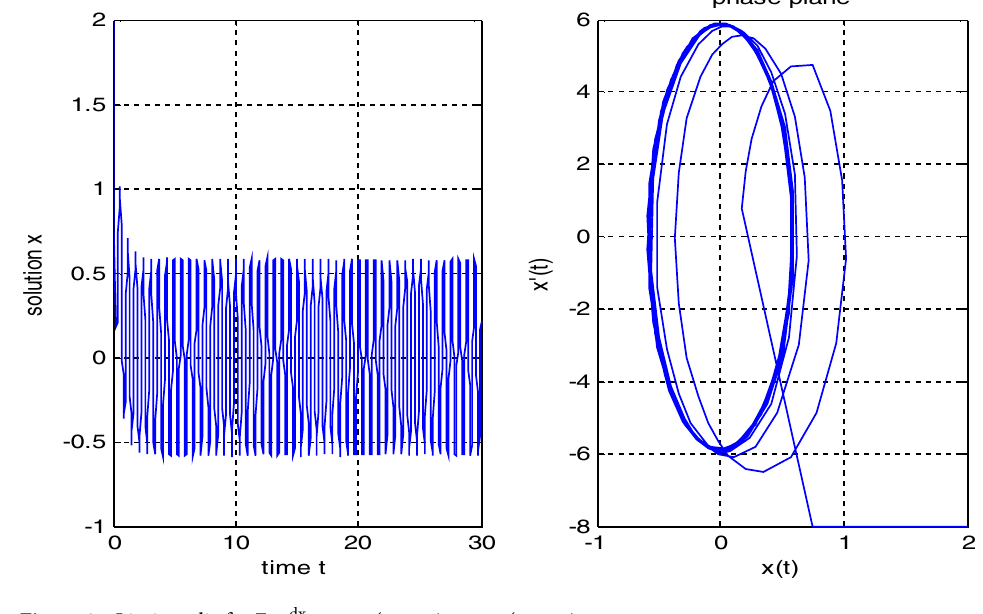
Figure 3. Limit cyclic for Eq. dx dt